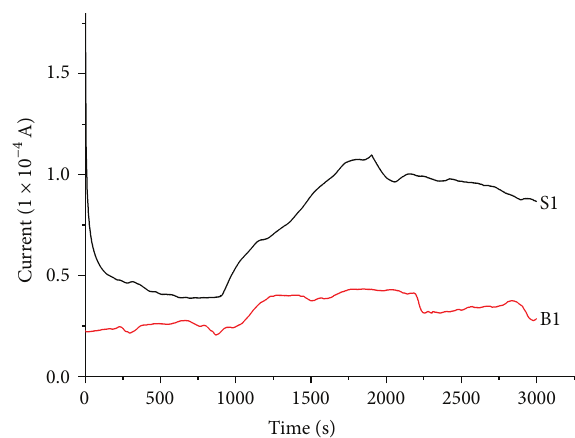
Figure 4: Current-time curves of the solar cell with and without spirulina under light and dark. B1: without spirulina; S1: with spirulina.